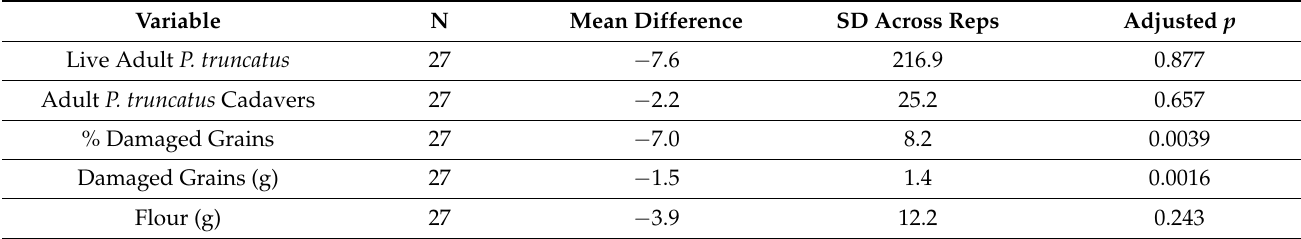
Table 1. Differences between flint and dent kernel types in the number of live adult P. truncatus and adult P. truncatus cadavers, percentage of damaged grains, and weight of damaged grains after an P. truncatus infestation period of 12